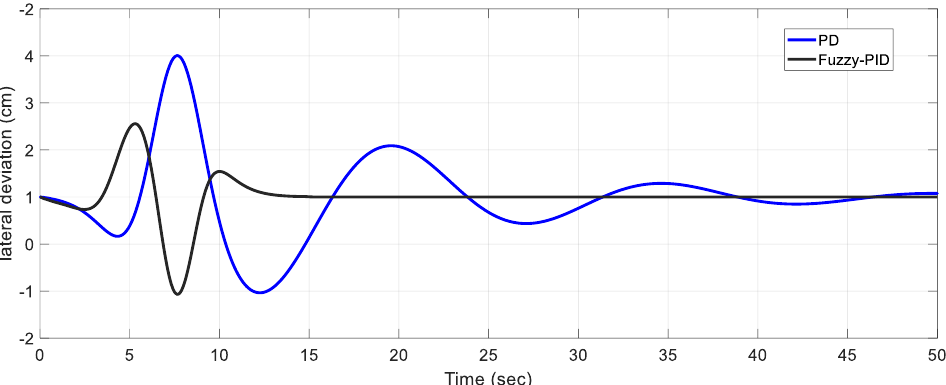
Figure 7. Comparing the fuzzy-PID and Ziegler – Nichols PD control.